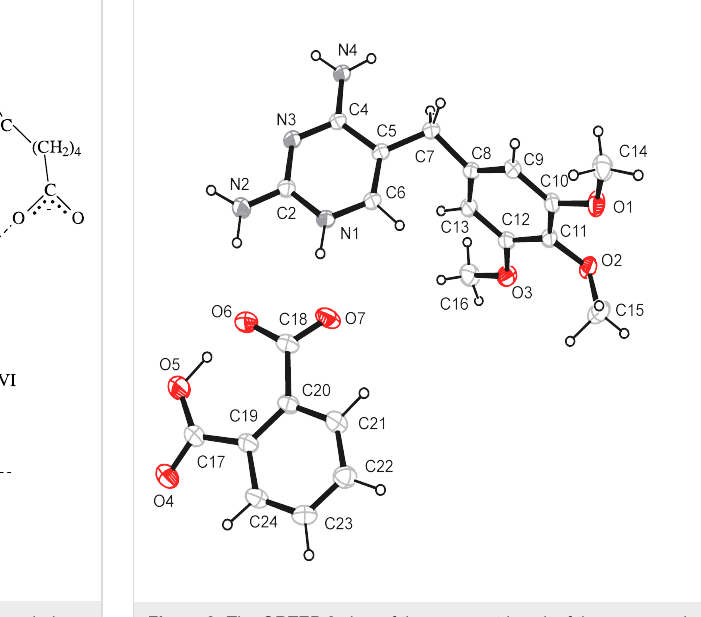
Figure 3: The ORTEP 3 view of the asymmetric unit of the compound 1